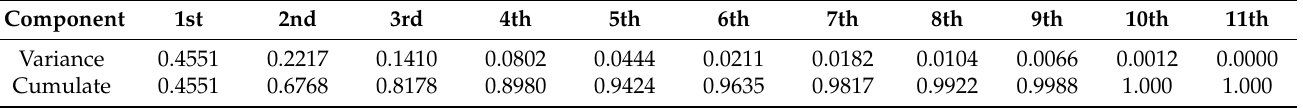
Table 2. Principal component analysis ( PCA ) with component variances and cumulate variances.